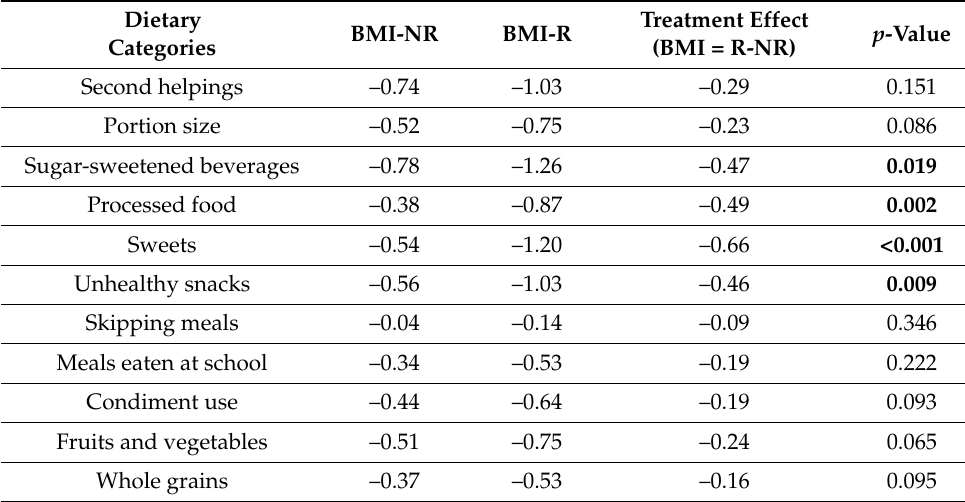
Figure 1. Health Behavior Score Trend over Time. Table 2. Changes in Health Behaviors from Initial to Last Visit.